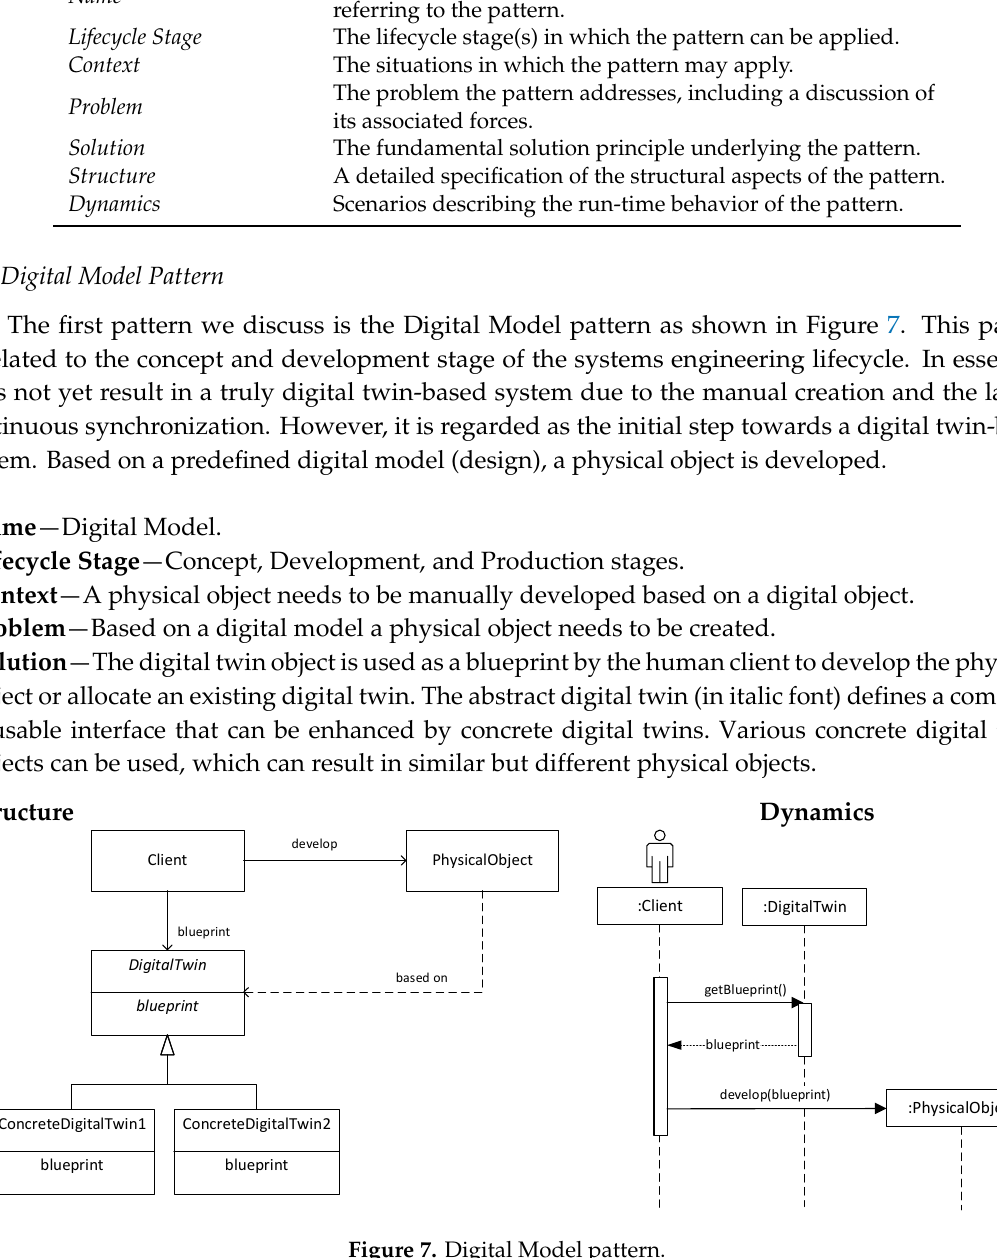
Figure 7. Digital Model